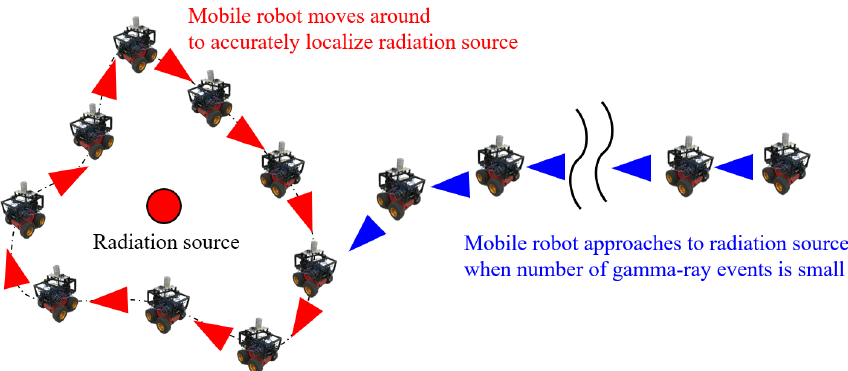
Figure 1. Conceptual image of measurement path: the proposed method is designed to approach the radiation sources to a distance where a sufficient number of gamma-ray events can be obtained, then, it generates a path to surround the radiation